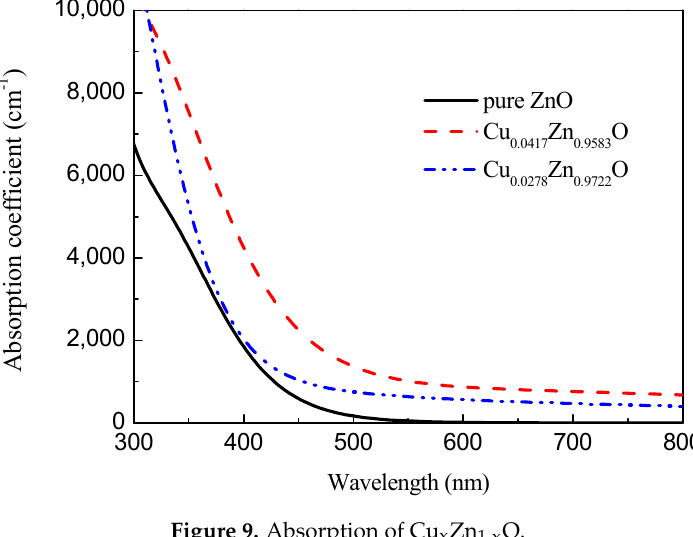
Figure 8. Absorption of pure ZnO.